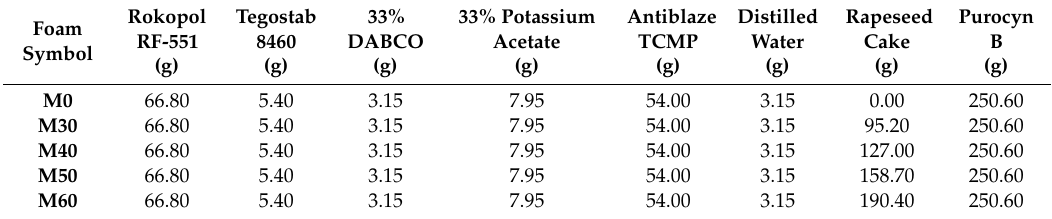
Table 2. Formulation of rigid polyurethane-polyisocyanurate (RPU / PIR) foams with rapeseed